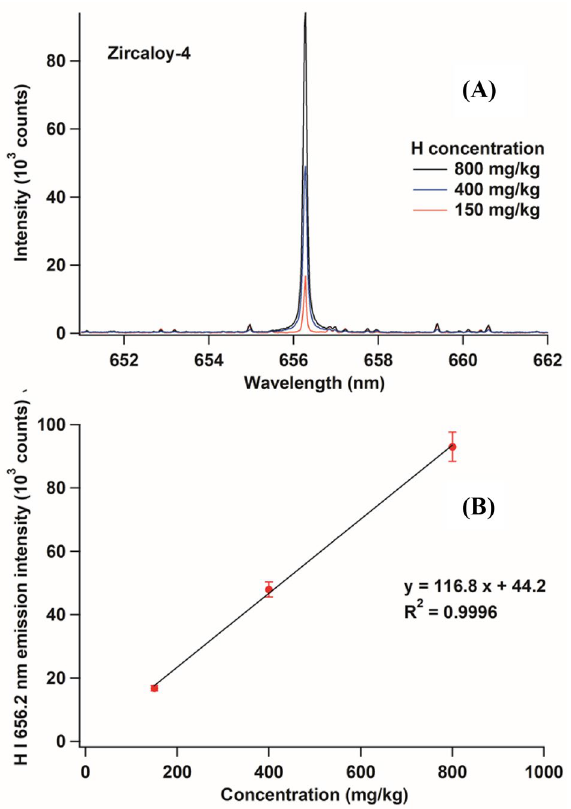
Figure 6. ( A ) Emission spectra of zircaloy-4 sample containing 150 mg/kg, 400 mg/kg, and 800 mg/kg of H. The conditions were the same as those mentioned in Fig. 4. ( B ) Intensity–concentration curve of H emission line derived from ( A